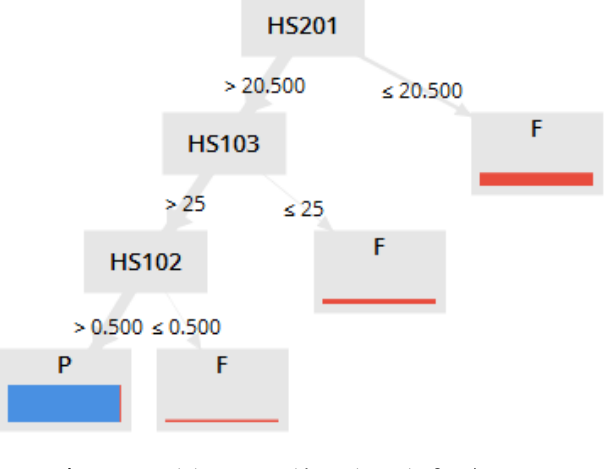
Fig. 13. Decision tree with Gain ratio for dataset 2